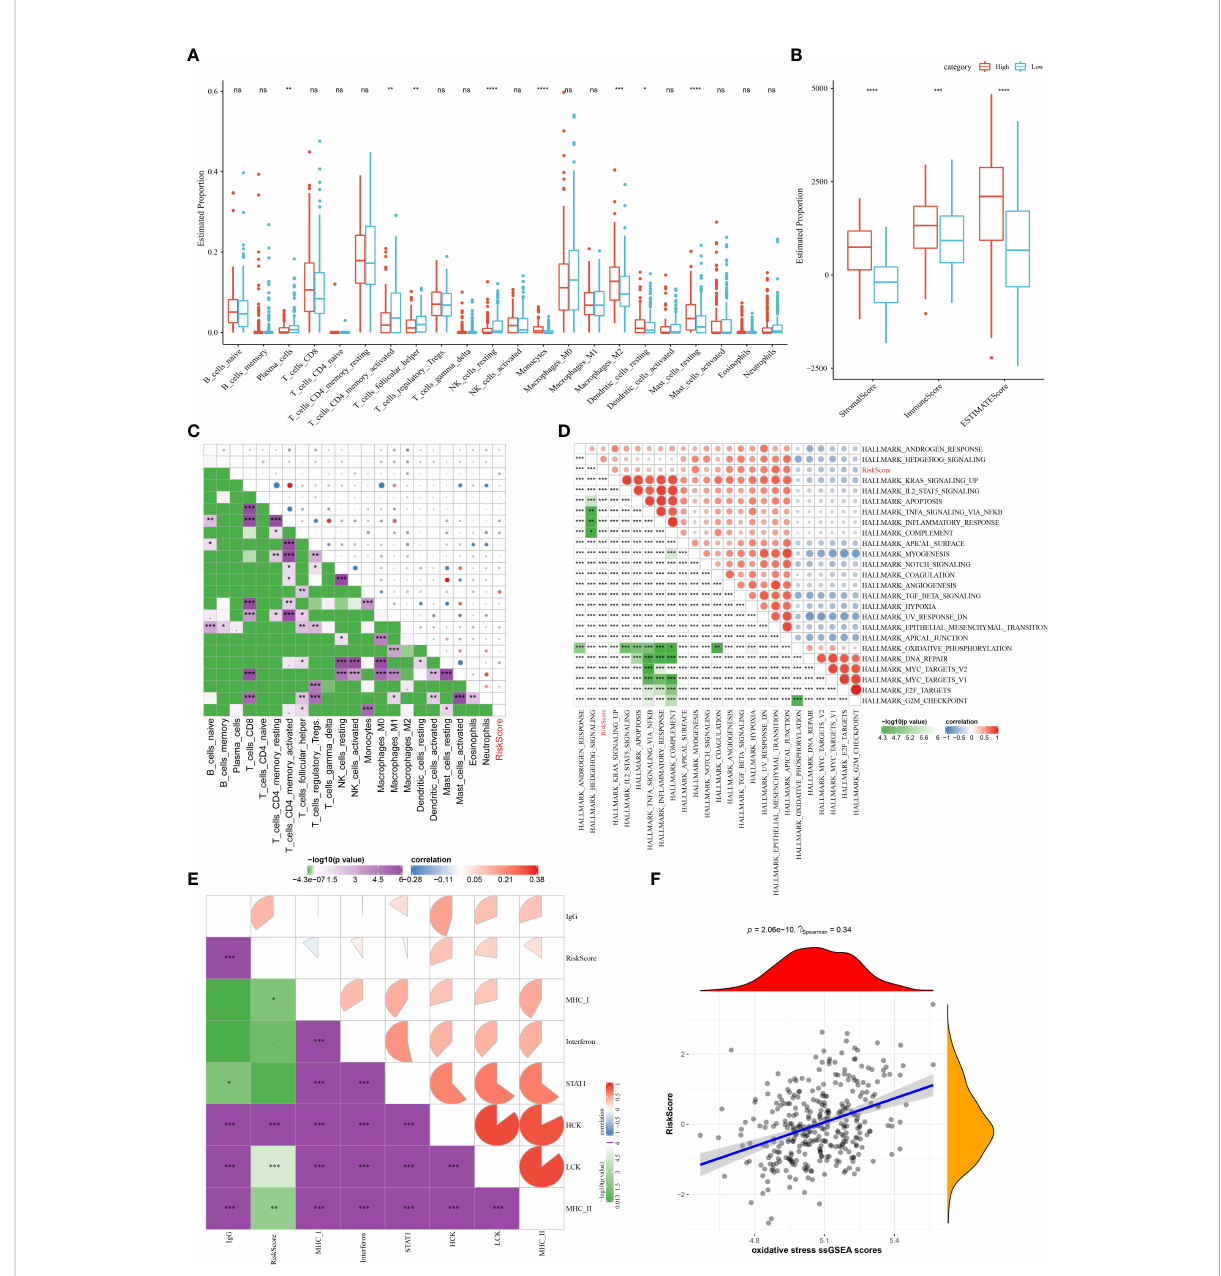
FIGURE 8 The associations between immune in fi ltration and biological functions in different risk group in the TCGA cohort. (A) The proportion of 22 immune cells between different risk groups; (B) Comparison of the stromal score, immune score, and ESTIMATE score between the high- and low-risk groups. (C – F) Correlation analysis of the risk score and 22 immune cells, biological functions, in fl ammation-related genes, as well as the OS ssGSEA scores. ns, no signi fi cance. * P < 0.05, ** P < 0.01, *** P < 0.001, **** P <